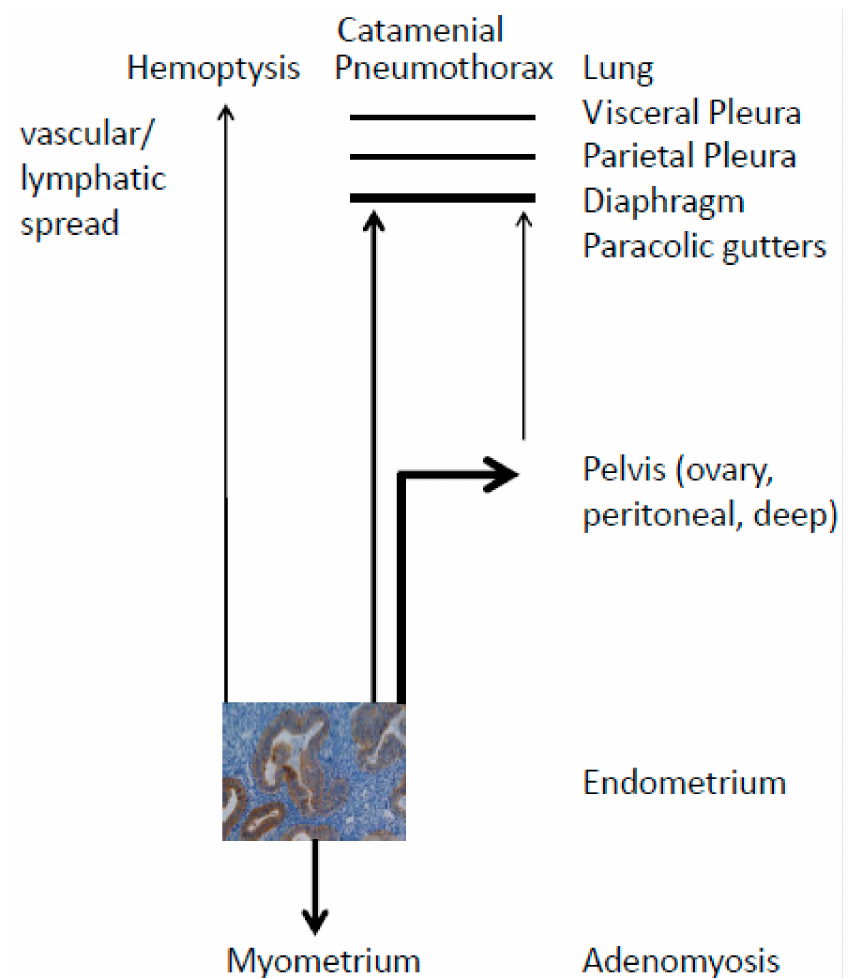
Figure 1. Scheme of the pelvic and thoracic endometriosis. Endometrial glands with the surrounding stroma are the basic unit in the endometrium as shown with claudin-4 positive glands in brown. After tissue breakdown, most often by menstruation, the glands/stroma invade the myometrium, the pelvis, or extra-pelvic sites. The most probable and most common migration of the lands/stroma is via the fallopian tube into the pelvis (retrograde menstruation). However, very rarely the glands/stroma also invade via the right paracolic gutters the right diaphragm, the parietal and visceral pleura and sometimes even the lungs or some other extra-pelvic sites such as for example liver and brain (not shown). Very rarely, bilateral and left-sided invasions in the case of catamenial pneumothorax have been observed. In the case of hemoptysis, the vascular spread of the glands/stroma seems to be preferred. The different thickness of the arrows reflects the relative frequency of endometriosis at different ectopic sites. Modified from Omwandho et al.